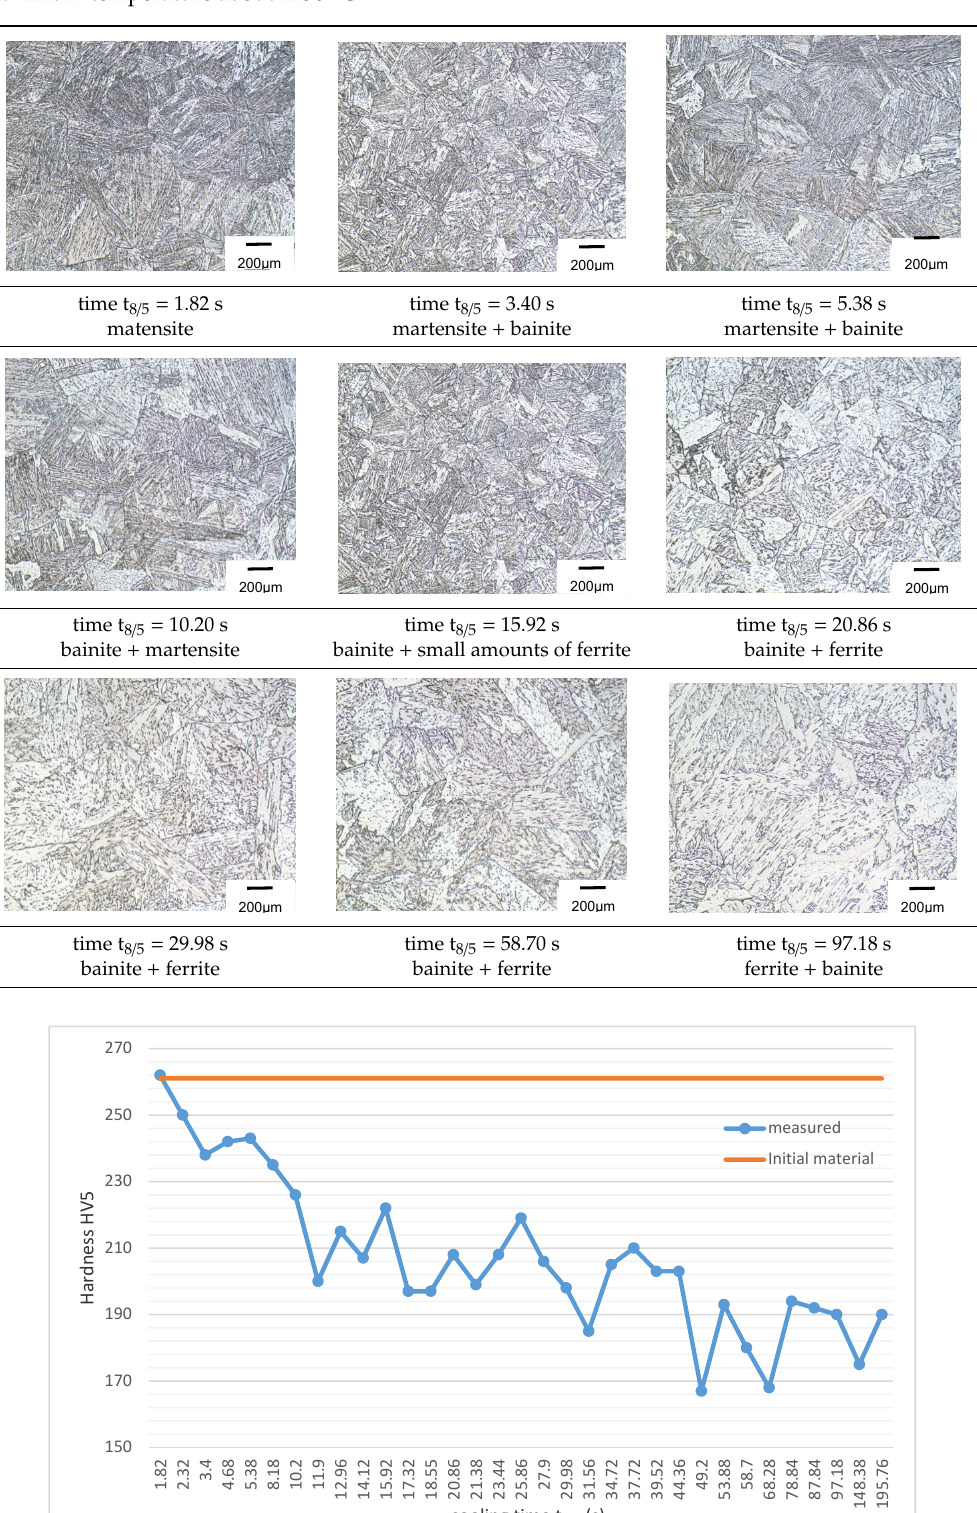
Table 7. The microstructure of HAZ of S700MC steel as a function of cooling time t 8/5 for a cycle of the maximum temperature about 1250 °C.